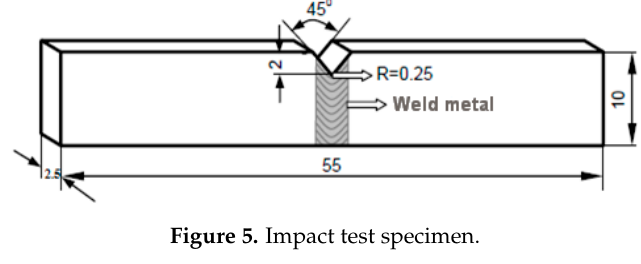
Figure 5. Impact test specimen.